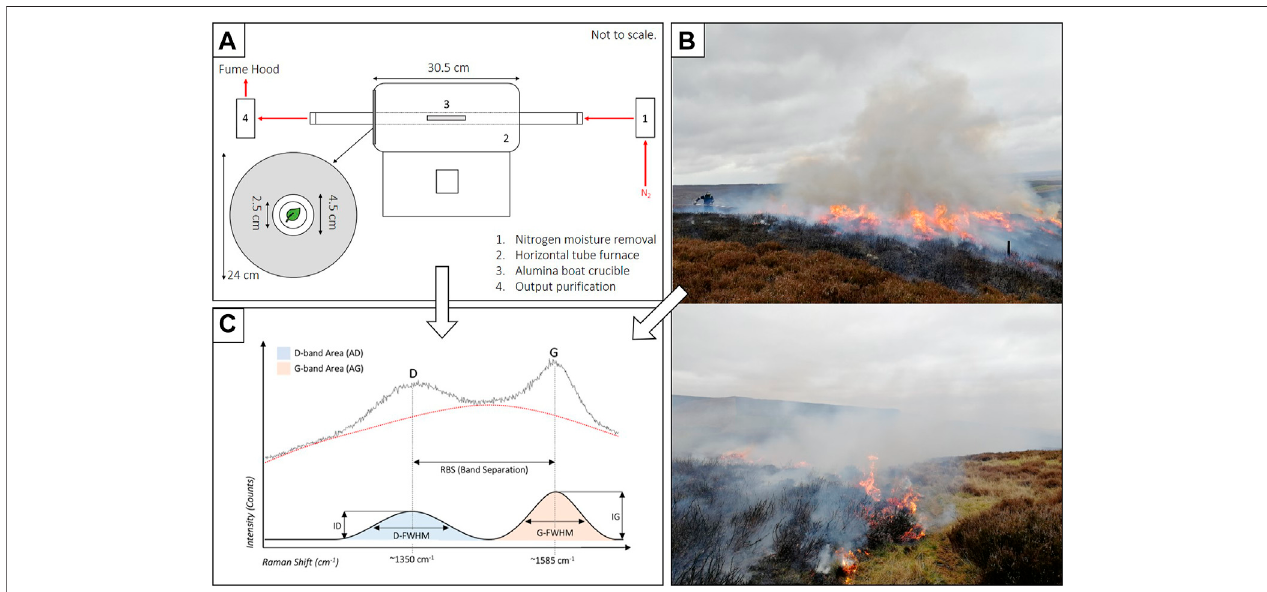
FIGURE 1| Adiagram highlighting the collective methodological componentswithin this study, including; (A) a schematic representation of experimental pyrolysis usingatubefurnaceunderaninertnitrogenatmosphere, (B) fi eldphotographsindicatingconditionsduring,andpropagationof,prescribed fi reintheGlensaugh Calluna heathland,and (C) arepresentationofthemethodbywhichappliedRamanparameters(labelled)areobtained via deconvolution,andtheirrelationshiptoarawspectrum (grey) and its baseline (red), after Theurer et al. (2021).